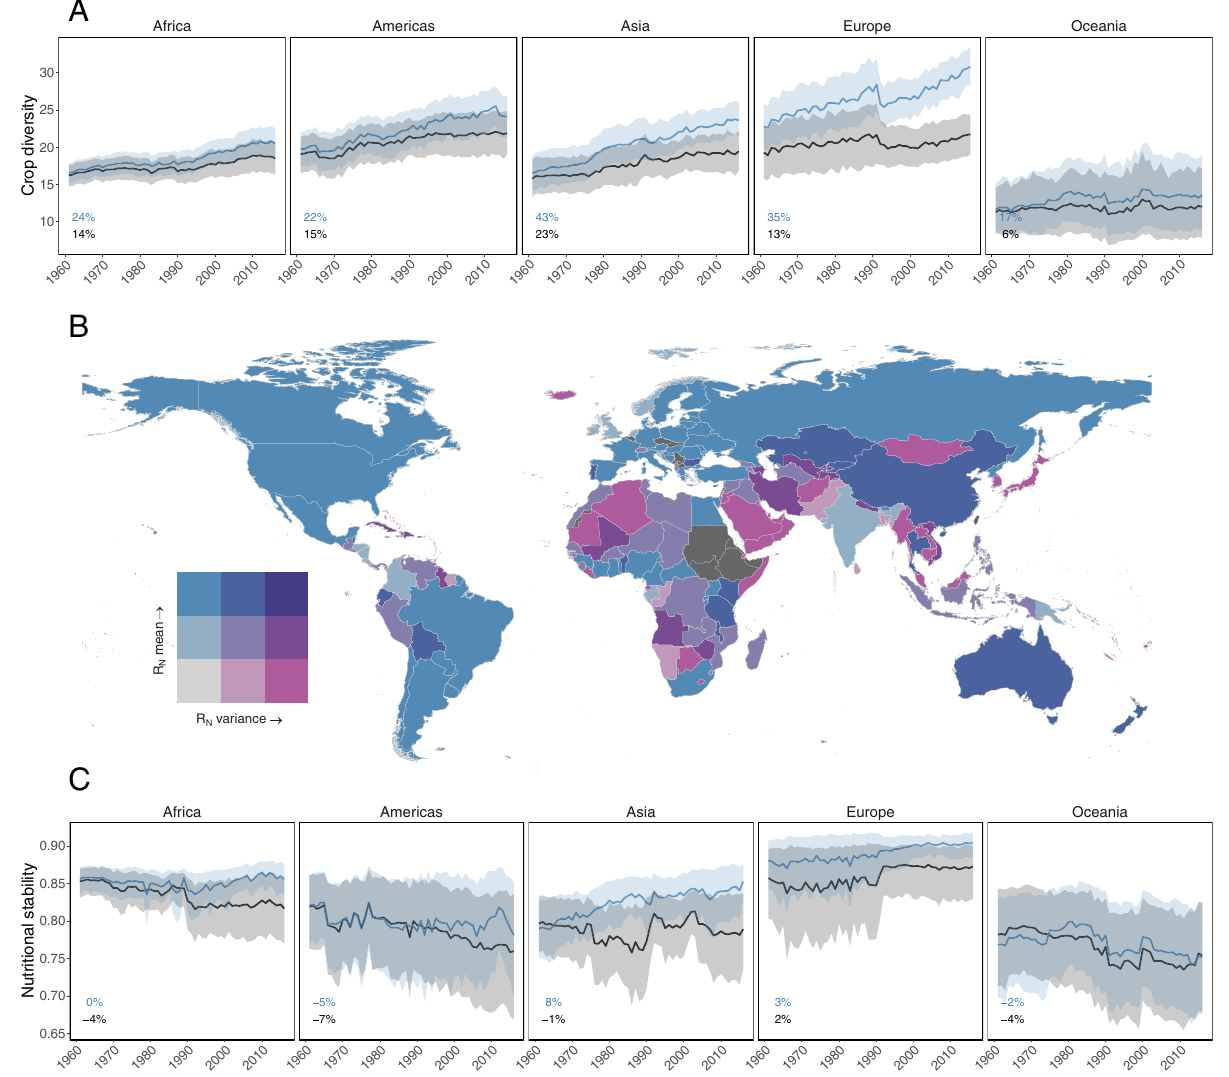
Fig. 3 Global patterns and trends of crop diversity and nutritional stability. Crop diversity increased over the 1961 – 2016 period for production plus imports (blue) and production alone (black) ( A ). Nutritional stability ( R N ) varies over space ( B ) and through time ( C ). The bivariate choropleth map depicts R N mean and variance for each country across years. For example, light purple countries experienced low average nutritional stability and high year-to-year variation. Countries fi lled with dark gray lacked suf fi cient data. Trends in R N ( C ) varied between regions and depended on supply source (Table 1), with Africa and Asia exhibiting diverging responses for food supplies derived from production plus imports and production alone. Trend lines depict regional means ± 95% con fi dence intervals. The percentage change over the 55-year period for each region and different supply sources is in the lower left of each